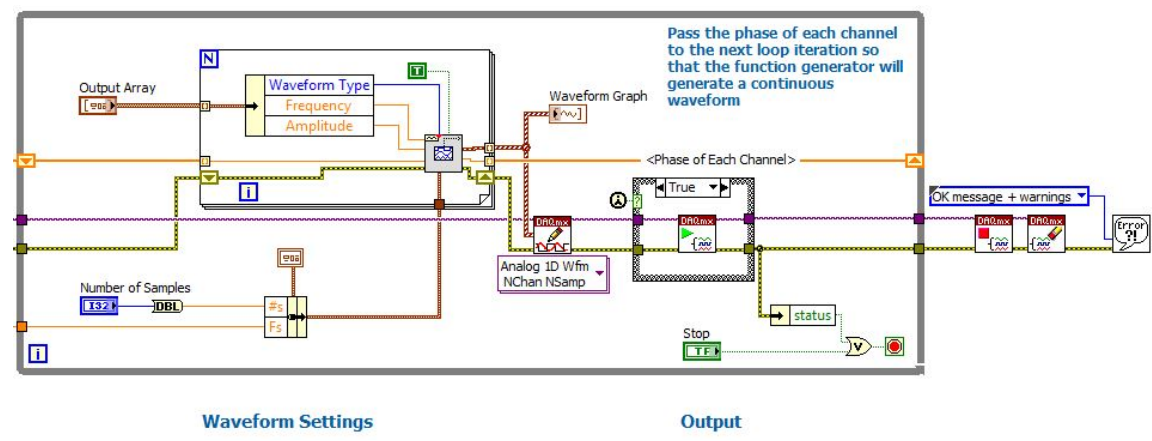
Figure 5. The second part of the block diagram panel.